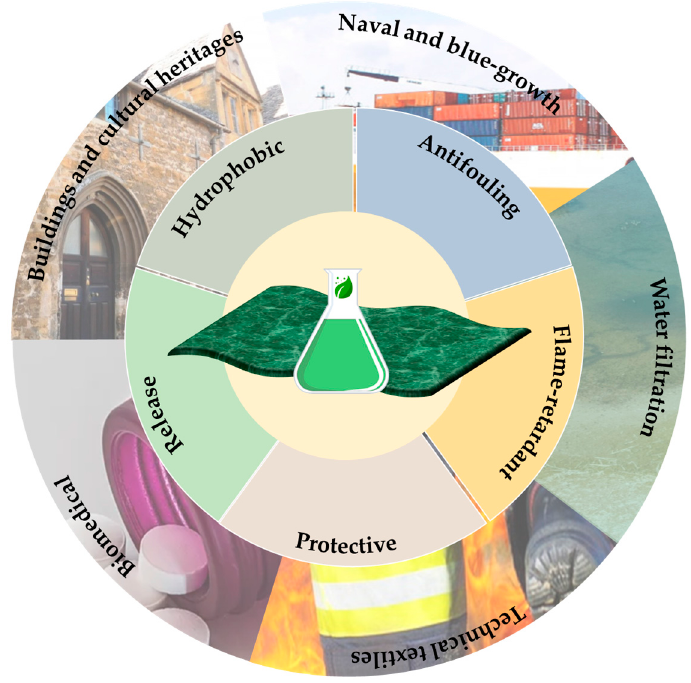
Figure 1. Functional and sustainable coating features and their potential application sectors.